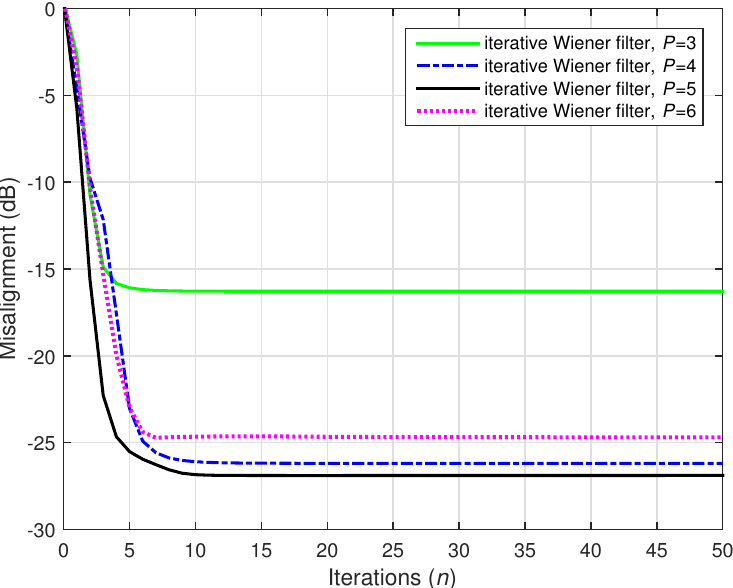
Figure 10. Performance of the iterative Wiener filter with different values of P , using N = 2000. The input signals were independent AR(1) processes, M = 4, L = 500, and SNR = 30